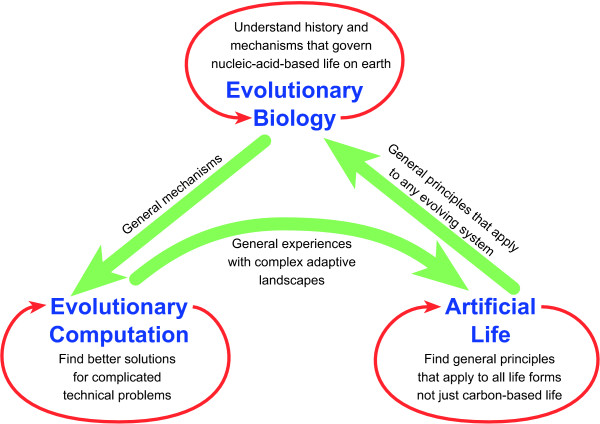
The three fields that study evolution. The red arrows encircle a goal central to each field. The green arrows denote major flows of inspiration and results. Each field has its own research agendas, conferences and journals.